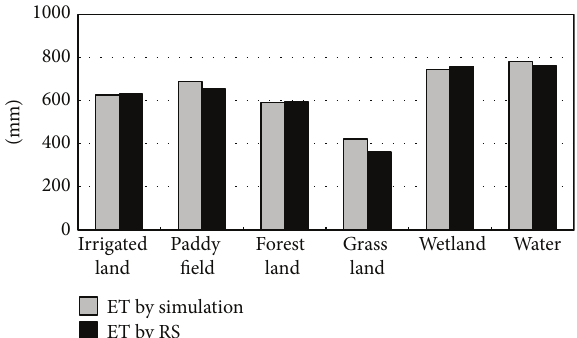
Figure 13: Comparison between simulated ET from the model and observed ET from RS in various lands.